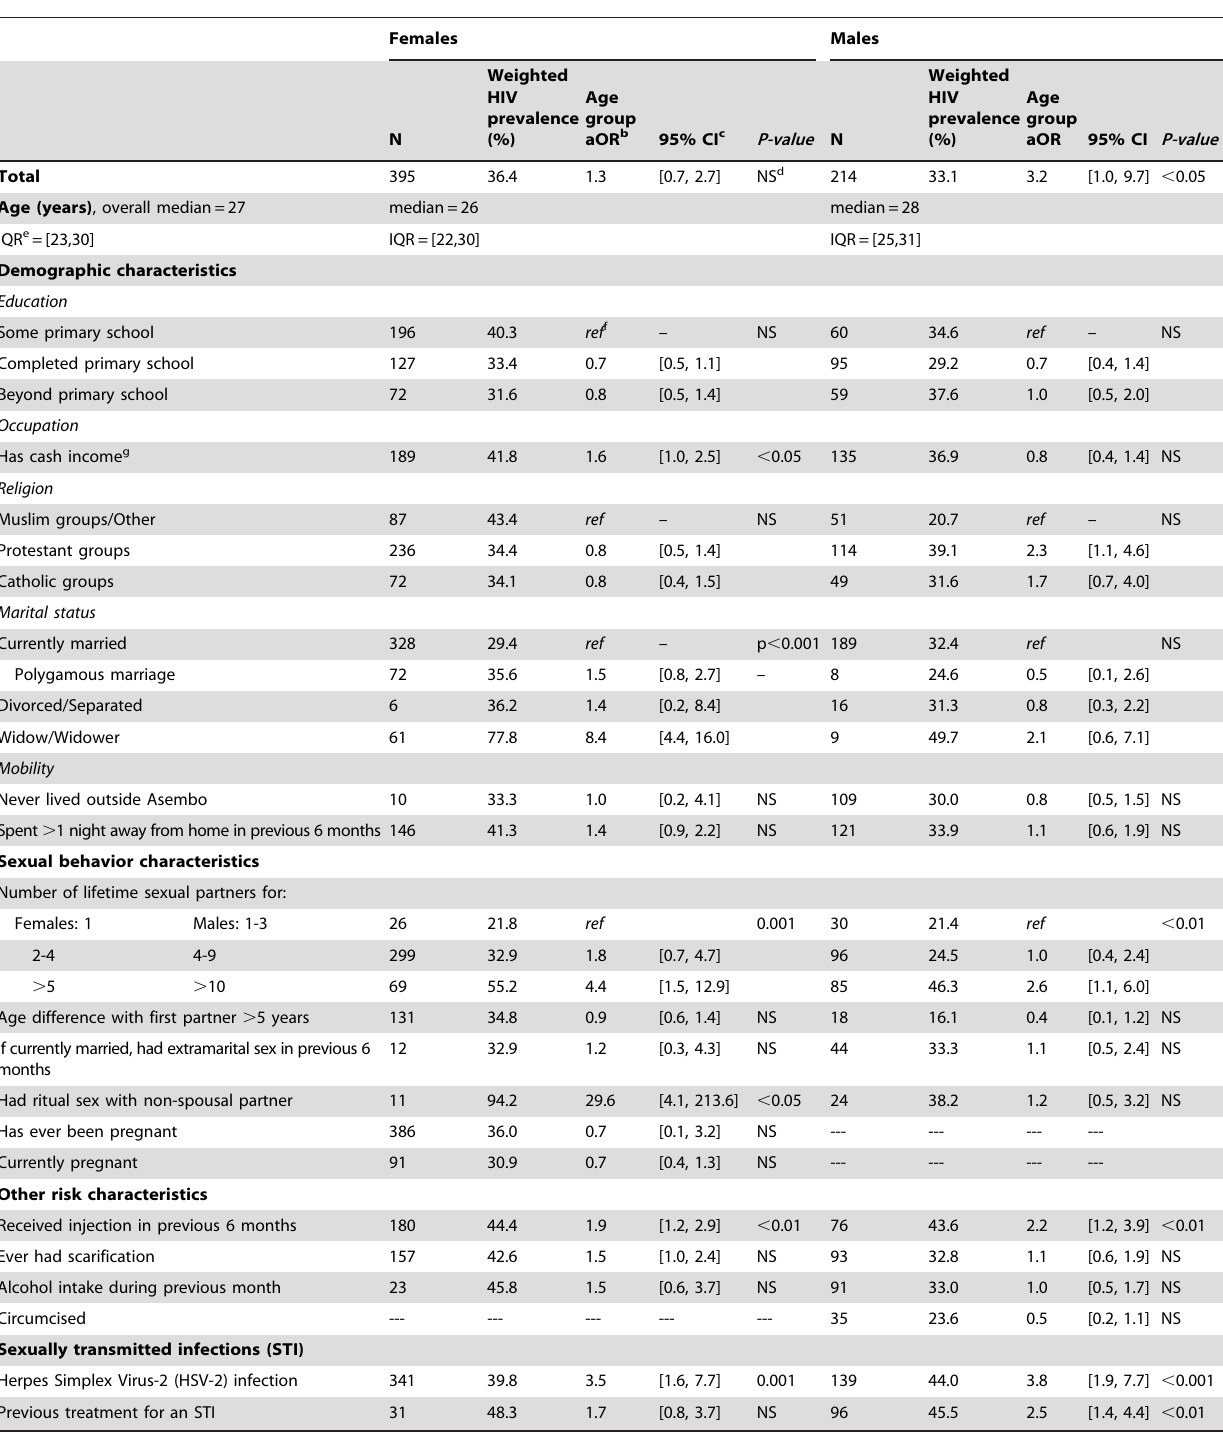
Table3. Age-groupadjustedriskfactorsassociatedwithHIVinfectionbygenderamongparticipantswhohaveeverbeenmarried a